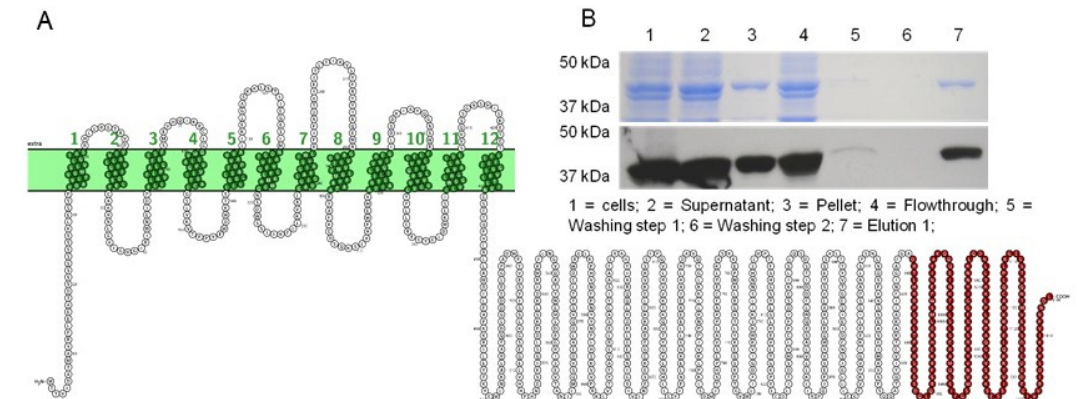
Figure 1. Expression and purification of the recombinant At SOS1 C-terminus (aa978–1146). ( A ) Model of the SALT-OVERLY-SENSITIVE1 (SOS1) antiporter; the target region used for the pull-down assay is marked in red. ( B ) SDS–PAGE and Western blot of purified At SOS1 C-terminus (aa978–1146). Glutathione-sepharose chromatography was performed using the GST-tagged fusion protein. 1: total proteins from At SOS1 C-terminus (aa978–1146) expressing E. coli cells; 2: supernatant (after centrifugation at 10,000 × g ); 3: cell pellet (after centrifugation at 10,000 × g ); 4: flowthrough; 5: washing step 1; 6: washing step 2; 7: elution 1 (apparent molecular mass was 44 kDa). The molecular mass (kDa) of the marker proteins is